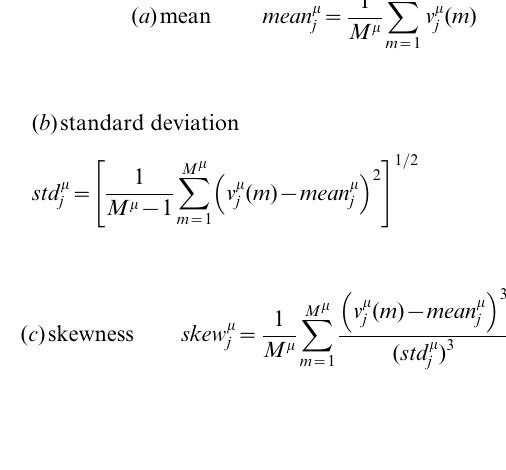
Table 1. List of the 31 markers used in the analysis.